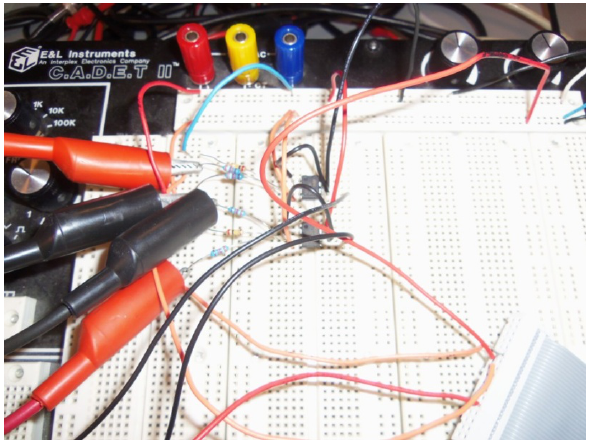
Figure 5. Signal conditioning circuits wired on breadboard